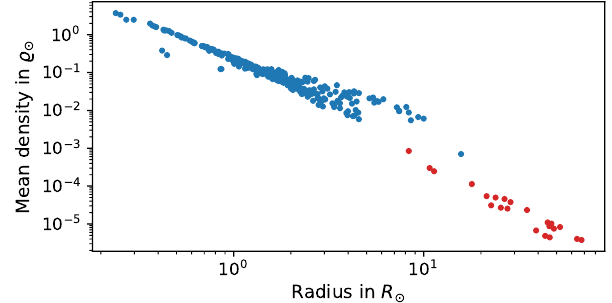
Fig. 30.— Plotting radius against density, both in solar units. Color marks red giants vs. main sequence stars. Data from DEB- Cat only generally larger in radius than main sequence